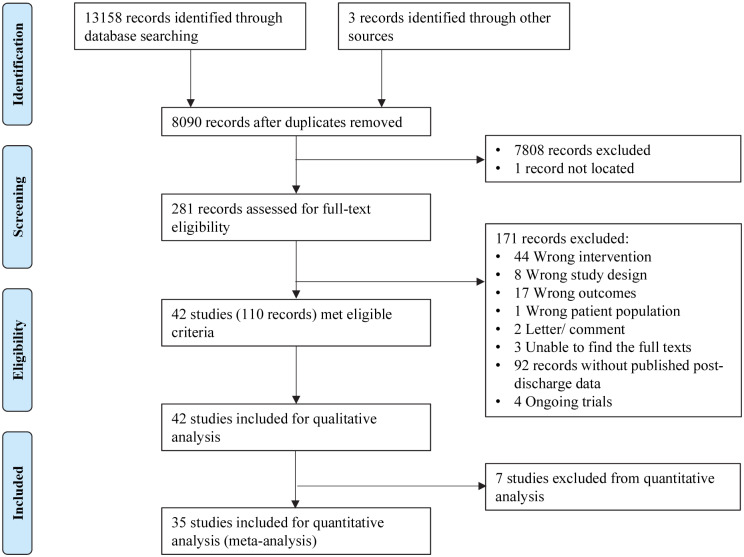
Flow diagram for included studies.